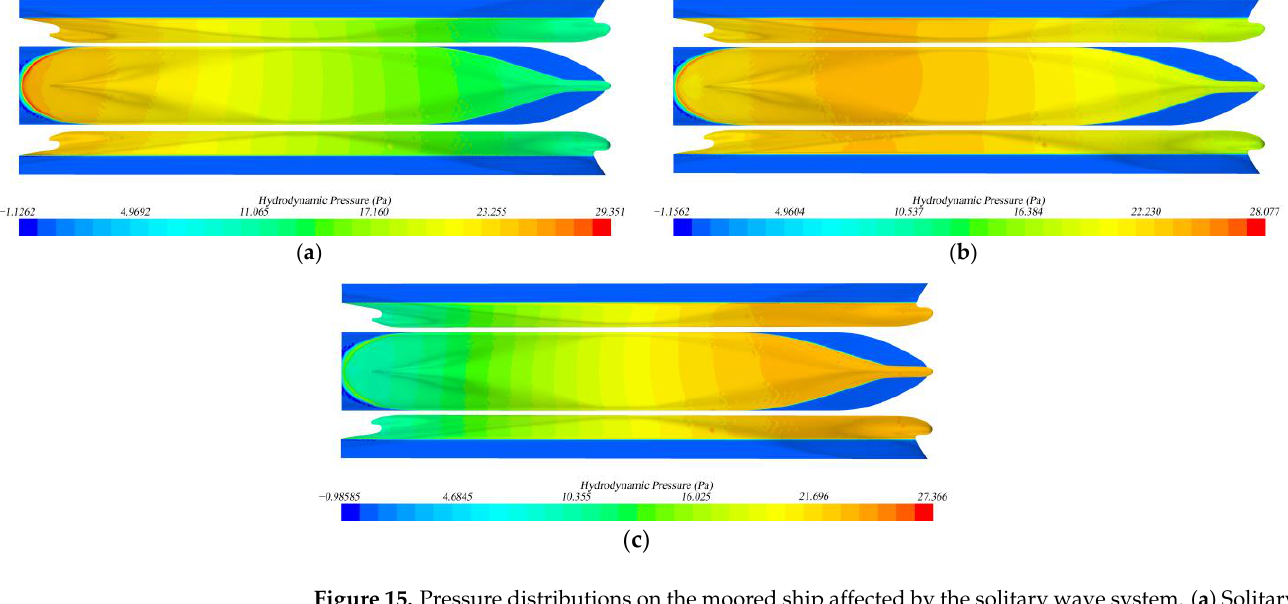
Figure 16. Pressure distributions on the moored ship affected by the primary wave system. ( a ) Pri- mary wave trough passing the stern, ( b ) Primary wave trough passing the midship, ( c ) Primary wave trough passing the bow. 6. Conclusions Aiming at developing a reliable numerical method to predict and investigate the ef- fects of ship waves generated by a passing ship on a moored ship in restricted waterways, this paper takes the benchmark model test case in the MASHCON2022 conference as the study object and numerically simulates the whole process of a ship passing a moored ship